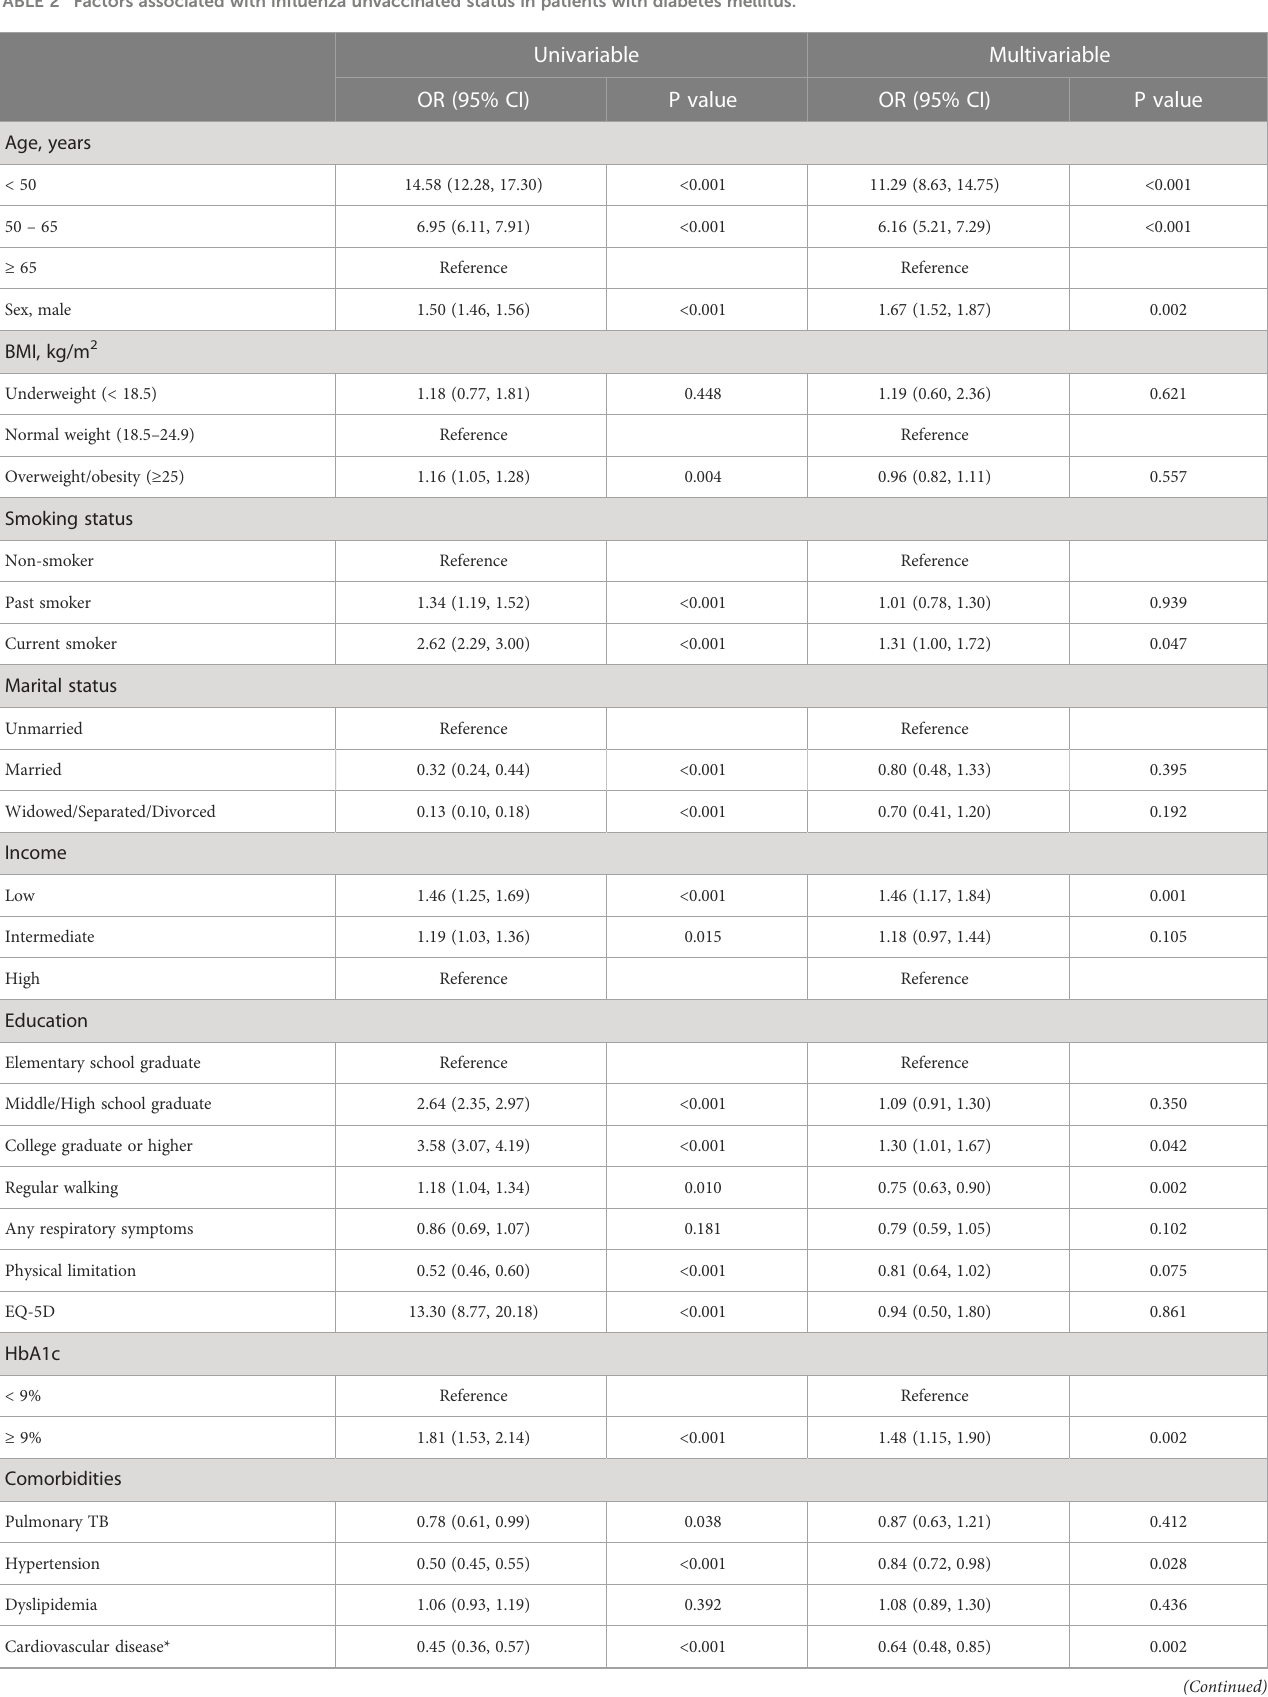
TABLE 2 Factors associated with in fl uenza unvaccinated status in patients with diabetes